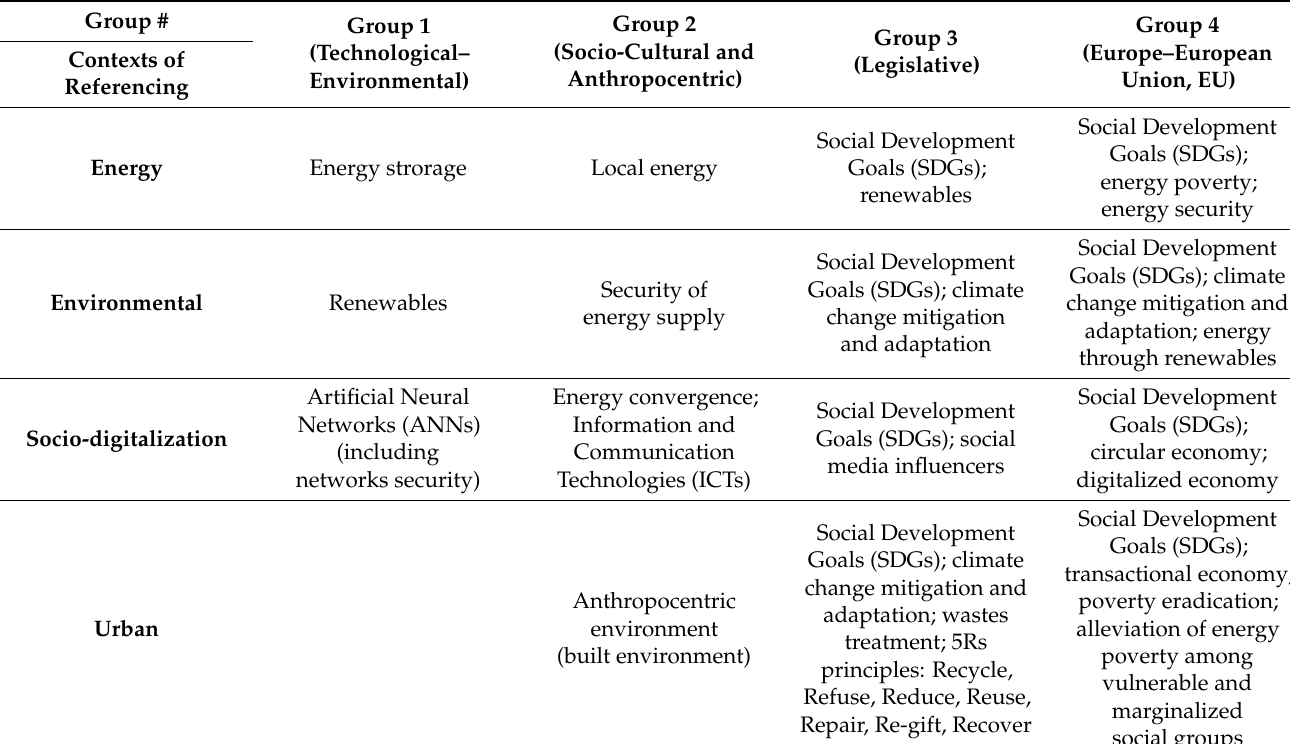
Table 1. Allocation of literature dimensions into contexts of energy communities per group: Group 1—technological and environmental dimensions of energy communities, Group 2—socio-cultural and anthropocentric dimensions, Group 3—legislative dimension, Group 4—Europe–European Union (EU) dimension of energy